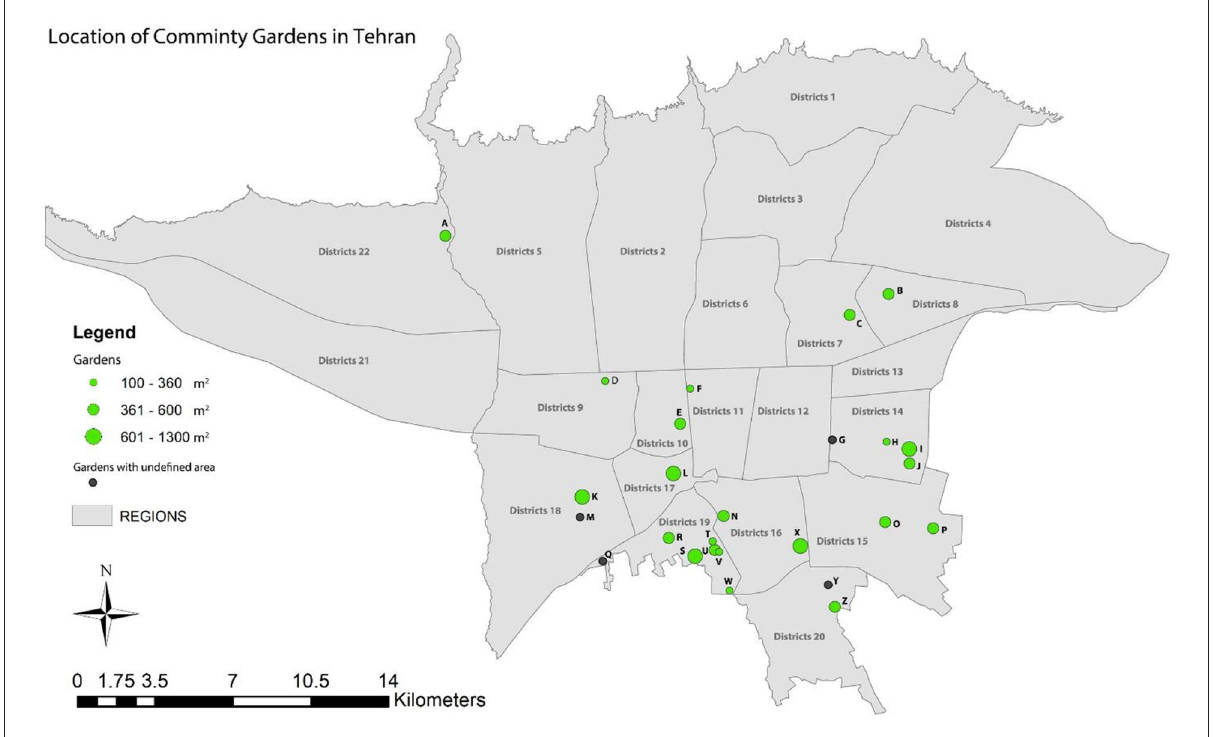
FIGURE2 Spatial distribution of gardens in the city of Tehran.